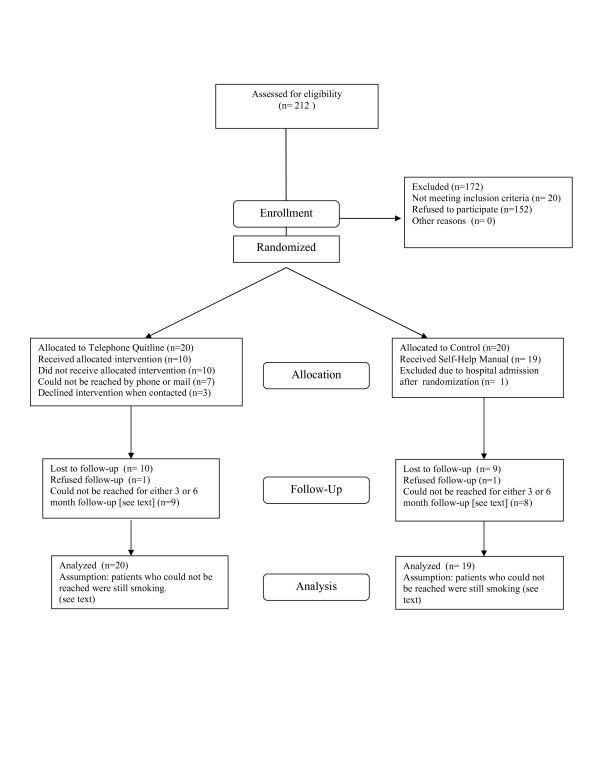
Study Flowchart.